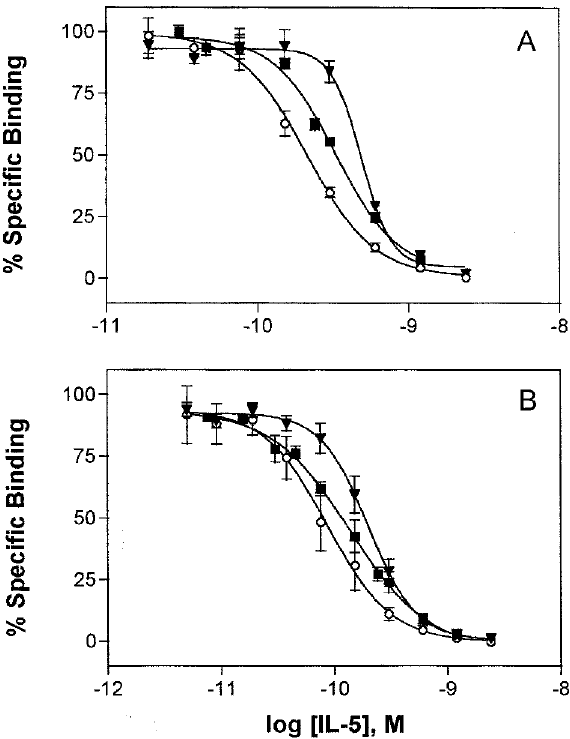
FIG. 3. Inhibition of [ 125 I]hIL-5 binding to human or guinea pig IL-5r by IL-5 orthologs. Membranes containing hIL-5r ab (A) or gpIL-5r ab 1 (B) were incubated with 50pM [ 125 I]hIL-5 in the presence of various concentrations of gpIL-5 ( . ), hIL-5 ( j ), or mIL-5 ( s ). Data are expressed as percent of control binding and represent the mean±SEM from three experi- ments performed in